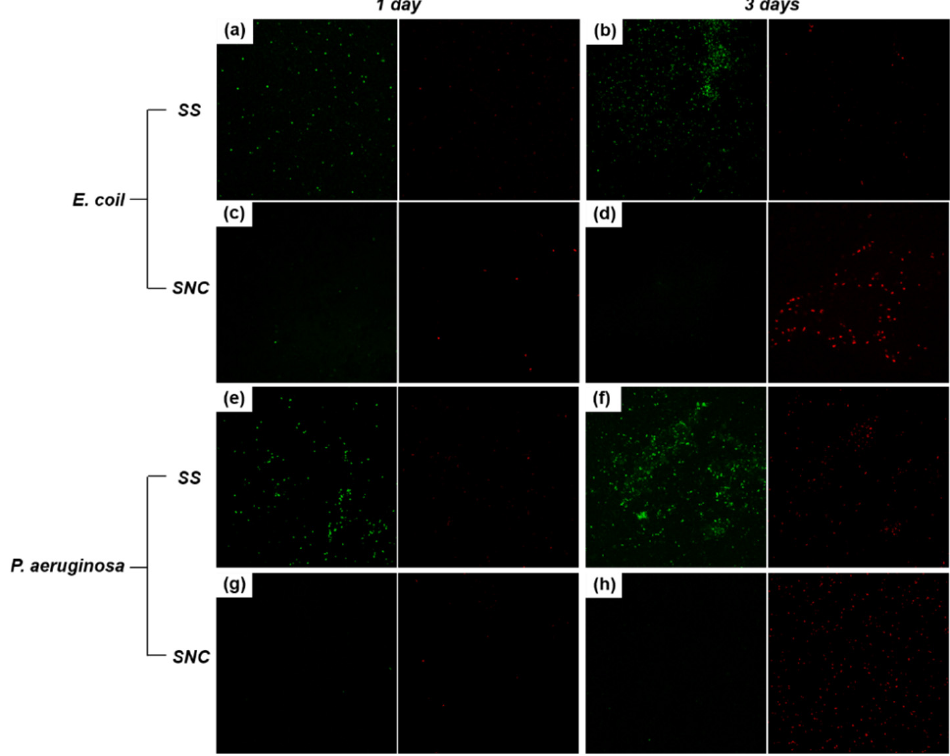
Figure 9. Fluorescence microscope images of E.coli on the SS after ( a ) 1 day and ( b ) 3 days of immersion, and on the SNC after ( c ) 1 day and ( d ) 3 days of immersion in the culture medium; fluorescence microscope images of P. aeruginosa on the SS after ( e ) 1 day and ( f ) 3 days of immersion, and on the SNC after ( g ) 1 day and ( h ) 3 days of immersion in the culture